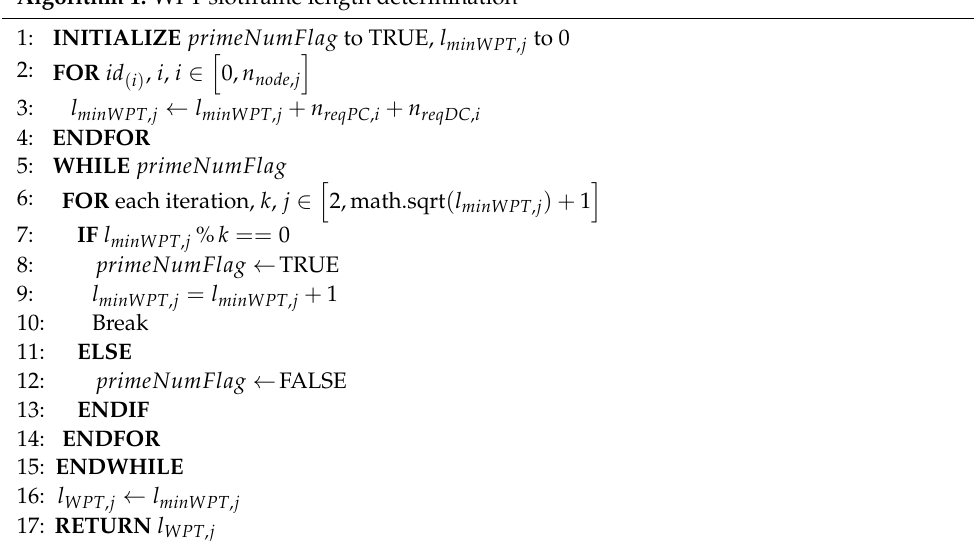
Algorithm 1. WPT slotframe length